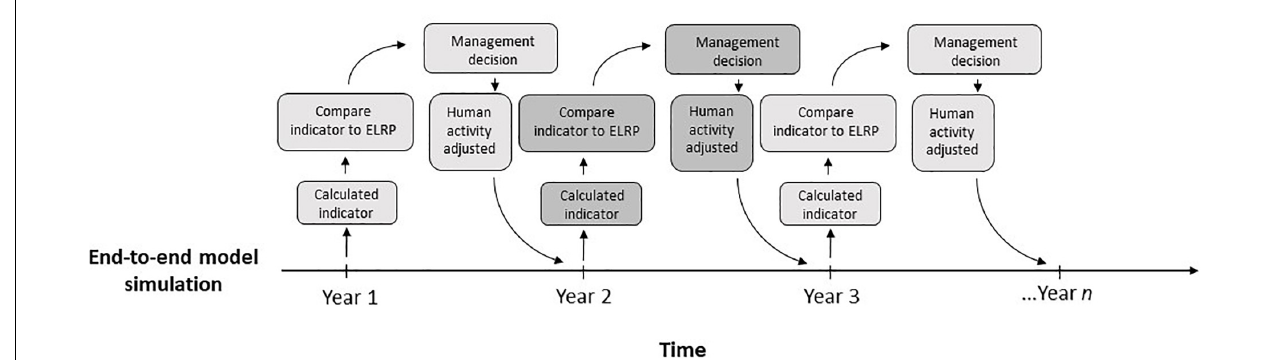
FIGURE 1 | Example of including indicator information into management decisions within end-to-end model simulation where the indicator for each time step is calculated and then compared to ecosystem-level reference points (ELRPs) or thresholds. A management decision is then made, and if necessary human activity is